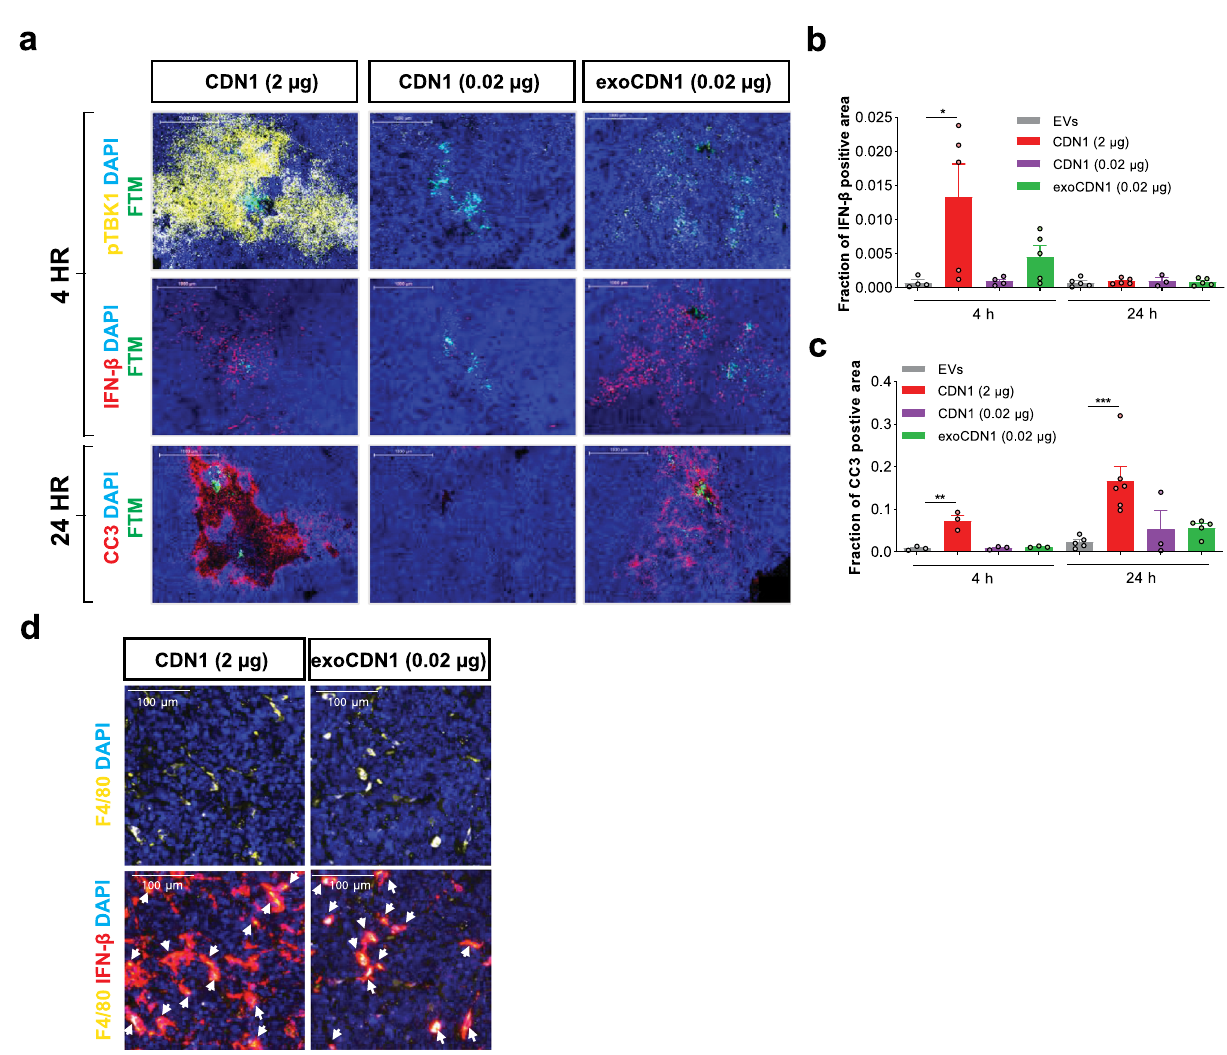
Fig. 7 exoSTING activates the STING pathway in APCs without collateral damage in tumors. a – d BALB/cAnNHsd mice were implanted subcutaneously with A20 B cell lymphoma cells (1 × 10 6 cells). Unloaded EVs, CDN1 (2 or 0.02 µ g), and exoCDN1 (0.02 µ g) were injected into tumor ( n = 6 animals) via the CIVO platform. a After 4 and 24 h, tumor sections were stained with pTBK1, IFN- β mRNA, and cleaved caspase 3 (CC3). IFN- β positive area ( b ) and CC3 positive area ( c ) were measured. Data are presented as means ± s.e.m from replicate samples as indicated. * P < 0.05; ** P < 0.01; *** P < 0.001 by one- way ANOVA with Tukey ’ s multiple comparison test. d Co-localization of F4/80 (yellow) and IFN- β (red) after free CDN (2 µ g) and exoCDN1 (0.02 µ g) treatment. White arrows indicate the co-localization of F4/80 and IFN-